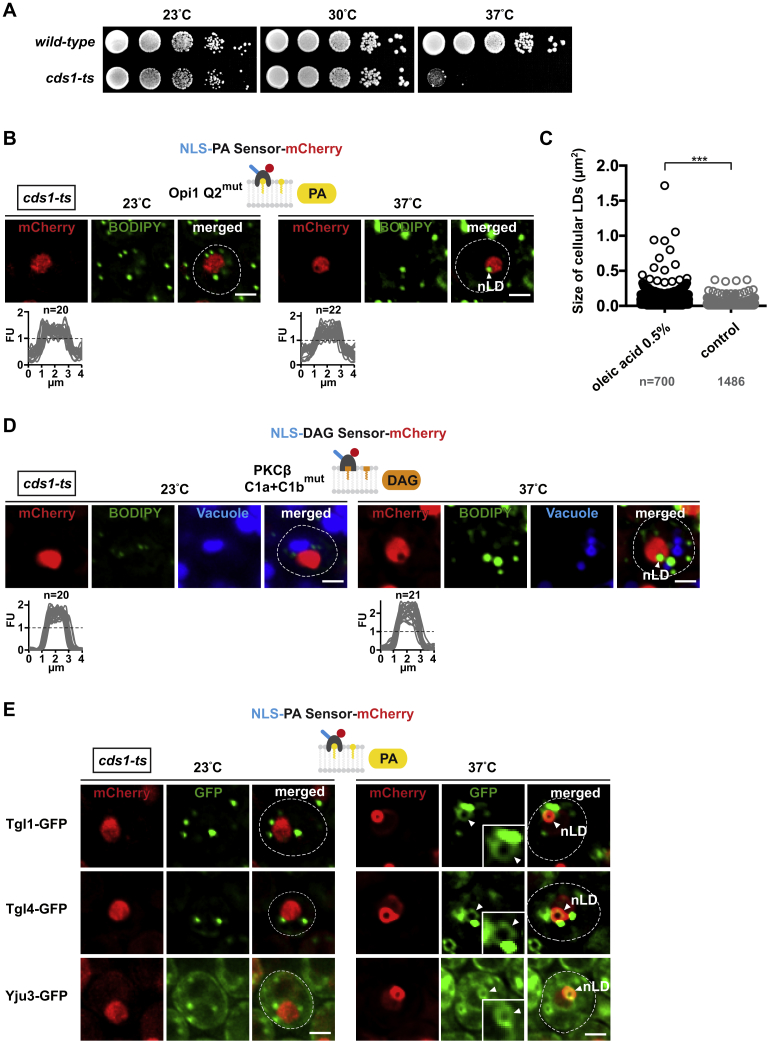
DAG, PA, and Enzymes of Lipid Metabolism Are Enriched on the nLD Surface, Related to Figures 2 and 3(A) Growth comparison of wild-type and cds1-ts cells at the indicated temperatures. Cells were spotted onto YPD plates in 10-fold serial dilutions and incubated for 2 days at indicated temperatures.(B) Live imaging of cds1-ts cells expressing a plasmid-based NLS-PA sensor mutated in residues critical for PA binding. The mutant sensor fails to recognize PA at the INM or on nuclear lipid droplets. Cells were grown at the indicated temperatures for 4 hours and co-stained with BODIPY to visualize lipid droplets. Line-scans were used to quantify sensor fluorescent intensity across the nucleus. n indicates the number of randomly selected cells, y axis: Arbitrary Fluorescence Units, FU; x axis: distance in μm. For comparison the FU value 1 is marked with a horizontal dashed line. Nuclear lipid droplet, nLD. Scale bar: 2 μm.(C) Automated quantification of lipid droplet size in wild-type cells upon oleic acid treatment. After setting identical fluorescence intensity thresholds, circular BODIPY structures were automatically selected and quantified using ImageJ. Number of analyzed cells is indicated. p value (∗∗∗ < 0.001) was determined by Wilcoxon signed-rank test.(D) Live imaging of cds1-ts cells expressing a plasmid-based NLS-DAG sensor mutated in residues critical for DAG recognition. The DAG pool at the INM and nLDs is no longer recognized as shown by the nucleoplasmic sensor signal. Cells were grown at the indicated temperatures for 4 hours and co-stained with BODIPY to visualize lipid droplets and CellTracker Blue for vacuoles. Line-scans were used to quantify sensor fluorescent intensity across the nucleus. n indicates the number of randomly selected cells, y axis: Arbitrary Fluorescence Units, FU; x axis: distance in μm. For comparison the FU value 1 is marked with a horizontal dashed line. Nuclear lipid droplet, nLD. Scale bar: 2 μm.(E) Live imaging of cds1-ts cells expressing GFP-tagged enzymes previously implicated in cytoplasmic lipid droplet metabolism. Cells co-express a plasmid-based NLS-bearing PA-mCherry sensor to visualize nLDs. Cells were grown for 4 hours at the indicated temperatures. Arrowheads highlight enzymes that co-localize with the PA-rich nLD monolayer. Other GFP-foci or circular structures reflect the association with cytoplasmic LDs. Inset shows magnified views of nLDs. Nuclear lipid droplet, nLD. Scale bar: 2 μm.